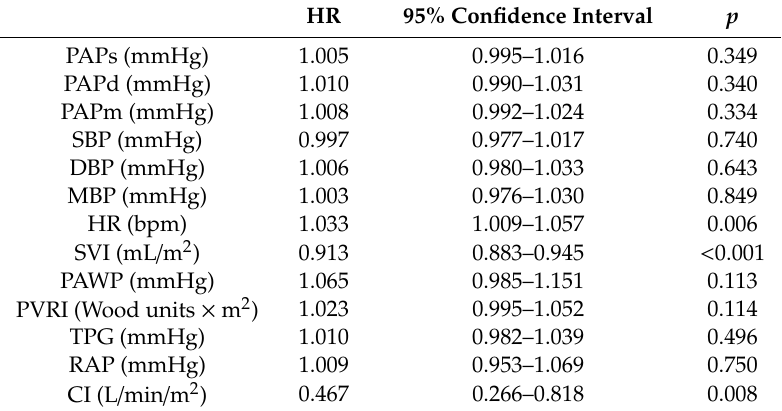
Table 6. Risk factors of death or lung transplantations in five-year follow-up. Univariable Cox regression analysis of hemodynamic parameters measured during iNO inhalation.